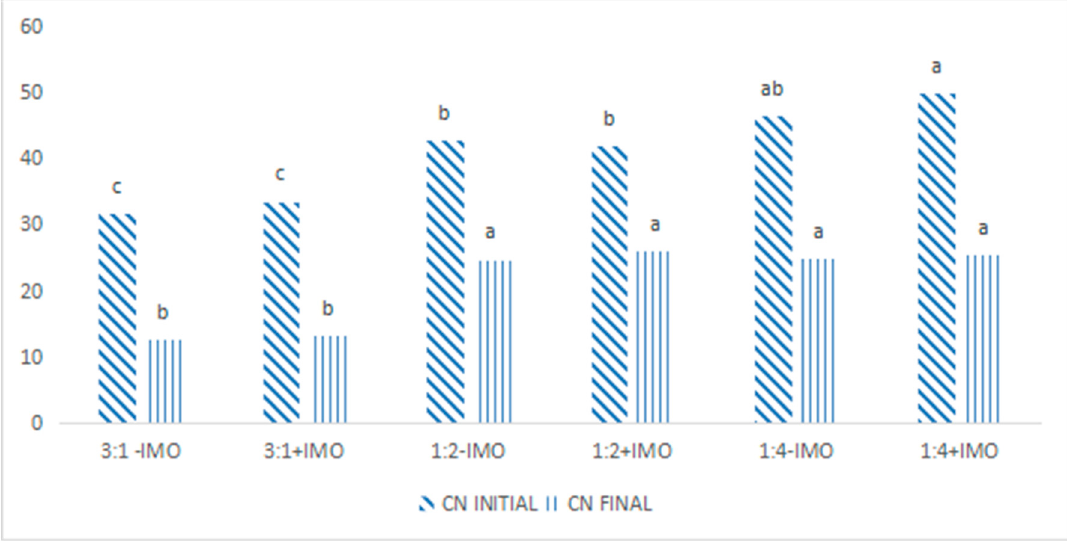
Figure 3. Initial and final C/N of composts. Footnote: similar letters on the bar chart across the treatments indicate not significantly different at p =0.05.